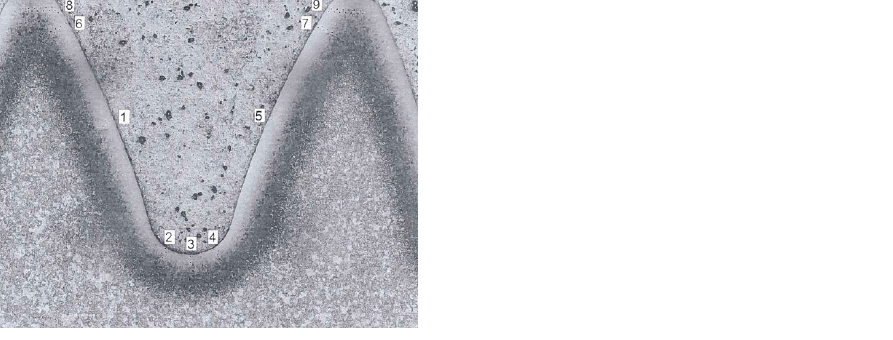
Figure 19. Carbon diffusion around the gear teeth for workpiece after the optimized Stream Finishing process.